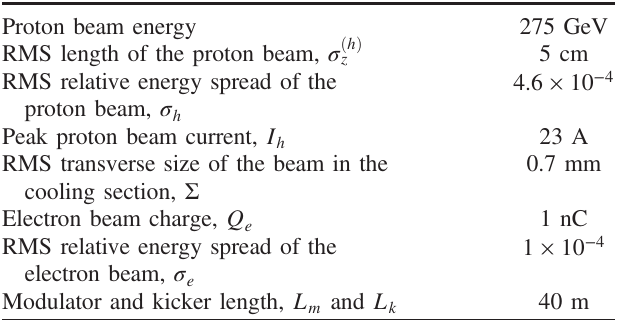
TABLE I. Parameters of the eRHIC collider with a hypothetical MBEC cooling